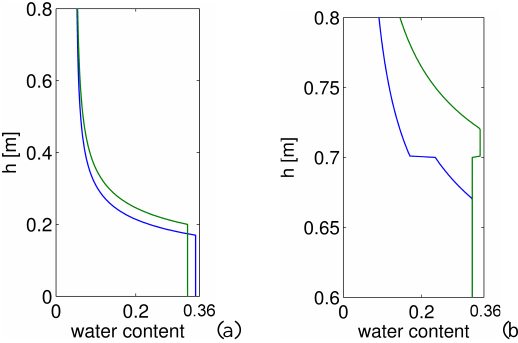
Fig. 4. (a) Conceptional impact of a compaction on a water retention curve (blue marks the non-compacted, green marks the compacted sand). (b) Exemplary water content distribution for different water tables (blue marks the lower water table) considering a compaction at 0.7m